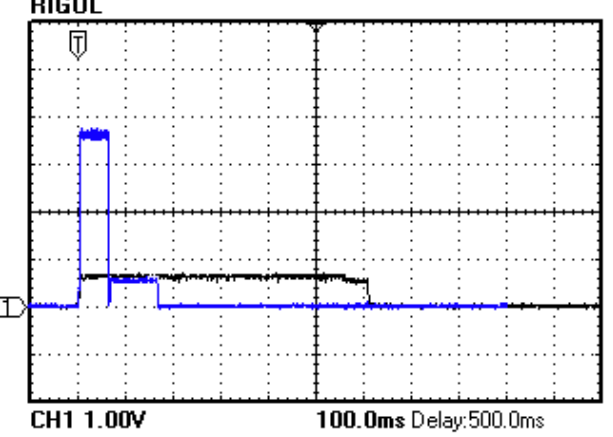
Figure 7 . Current consumption of joint photographic experts group (JPEG) compression at fixed frequency ( black ) and switched frequency ( blue ) with a quality value of 50 .